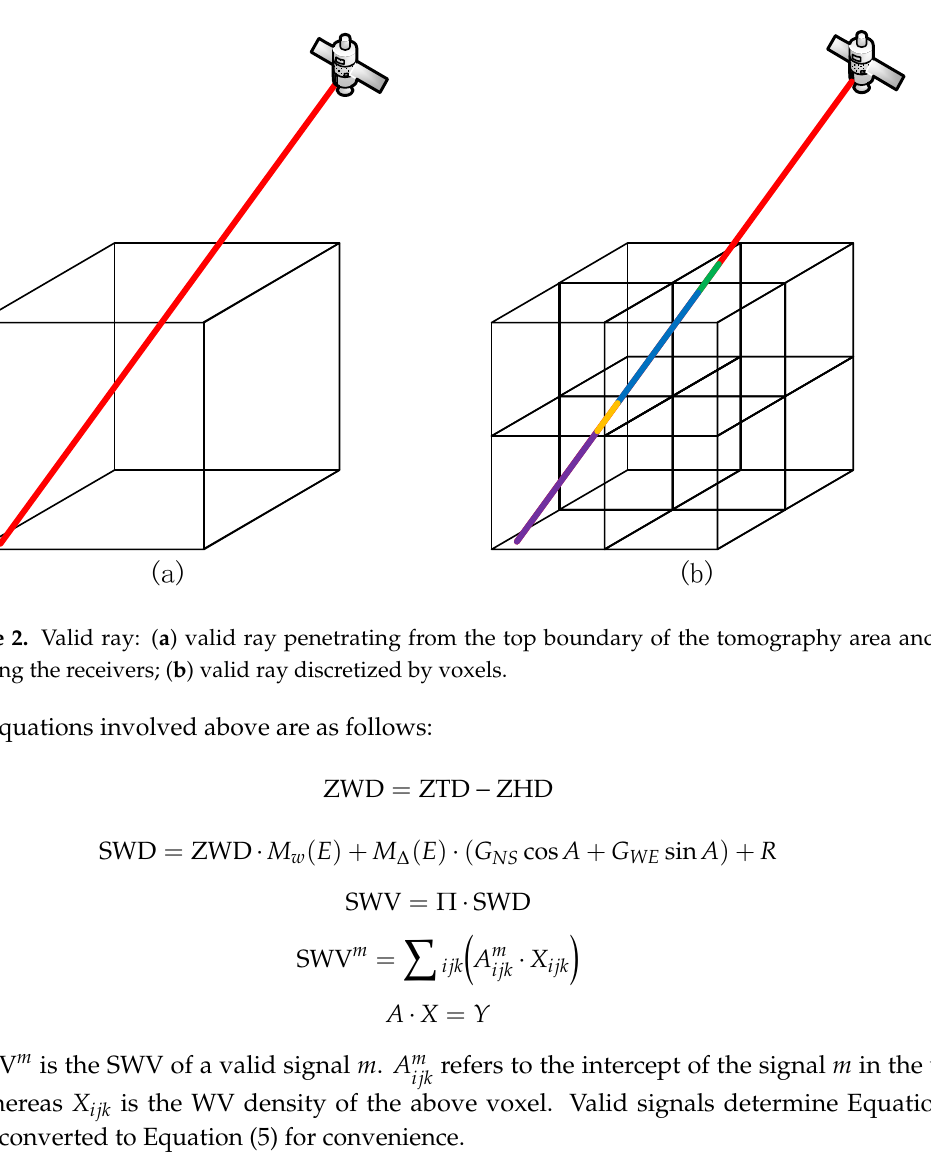
Figure 1. Process of reconstruction of the three-dimensional (3D) water vapor (WV) information using the global navigation satellite system (GNSS) tomography technique.